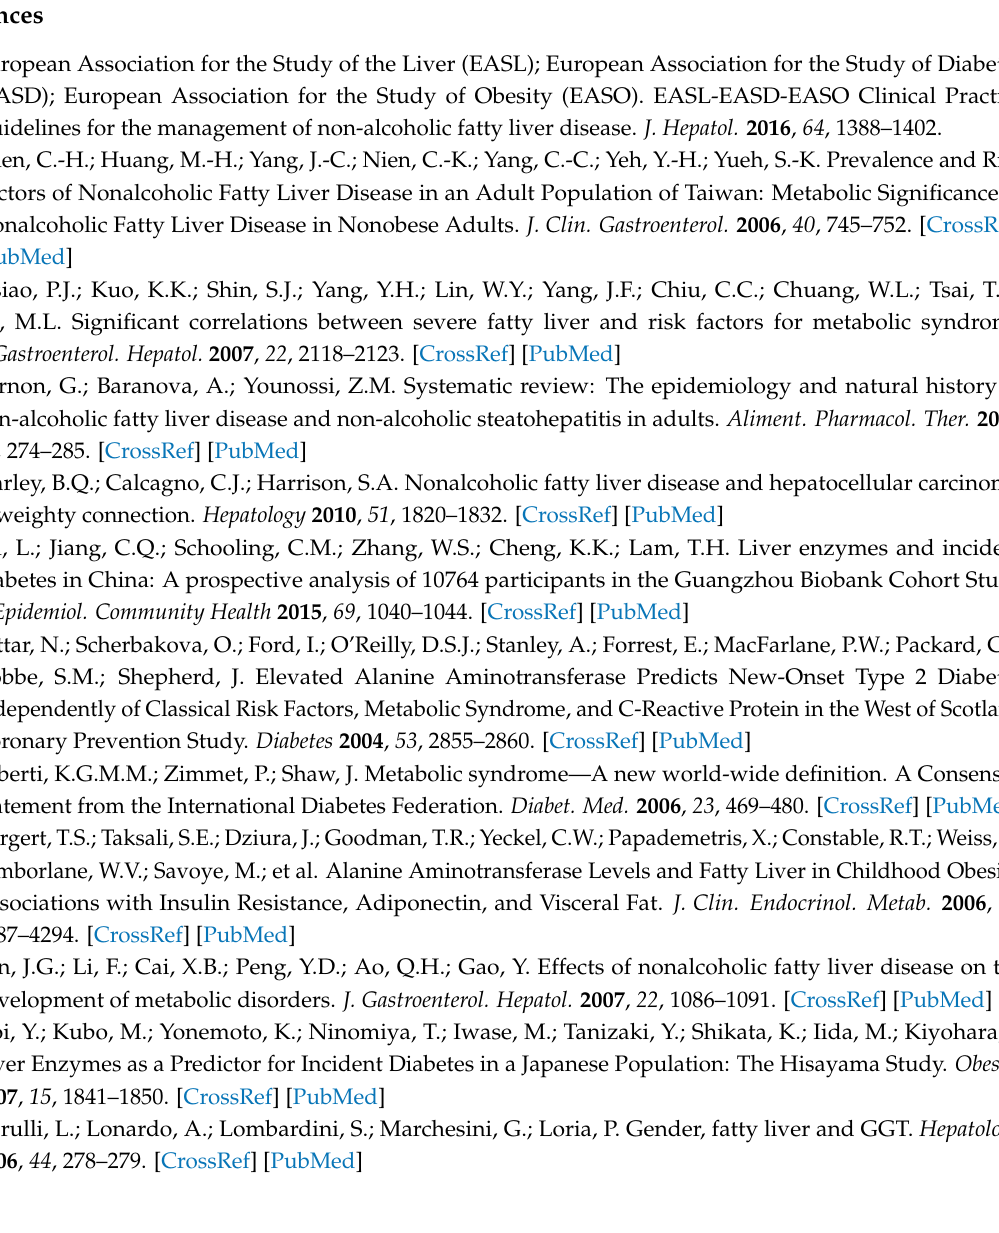
Table S1: Baseline Characteristics of the Study Cohort based on Serum ALT levels, Table S2: Univariate Analysis of Risk Factors Predicting Elevated ALT ≥ 30U/L in Women, Table S3: Multivariate Analysis of the Risk Factors Predicting Elevated ALT ≥ 30 U/L based on Sex, Figure S1: The age-based prevalence of elevated ALT in men and women. # Elevated ALTs are defined as ALT level ≥ 40U/L in men and ≥ 30 U/L in